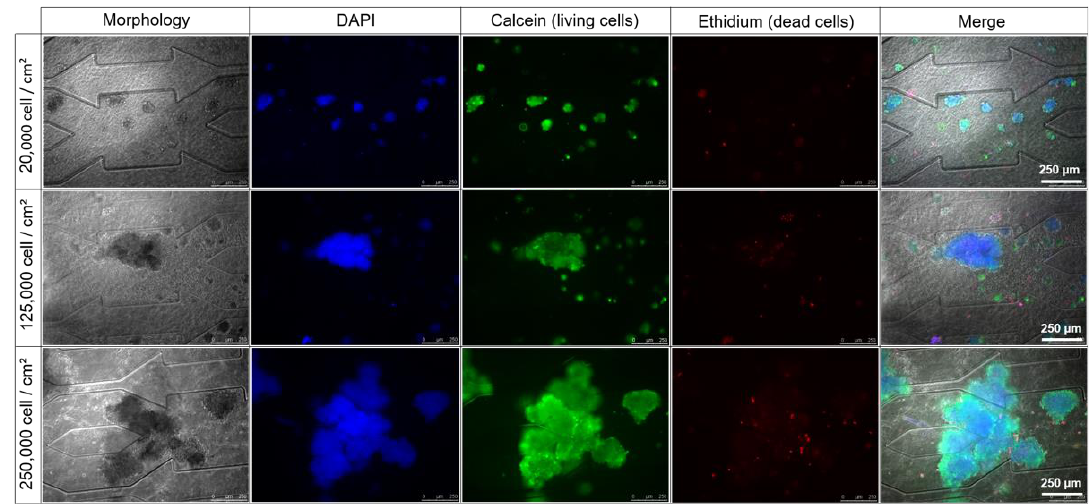
Figure 4. Cell viability for different seeding densities after 96h of culture in the biochip containing the hydroscaffold: DAPI (nuclei, blue), calcein (living cells, green), and ethidium (dead cells, red).